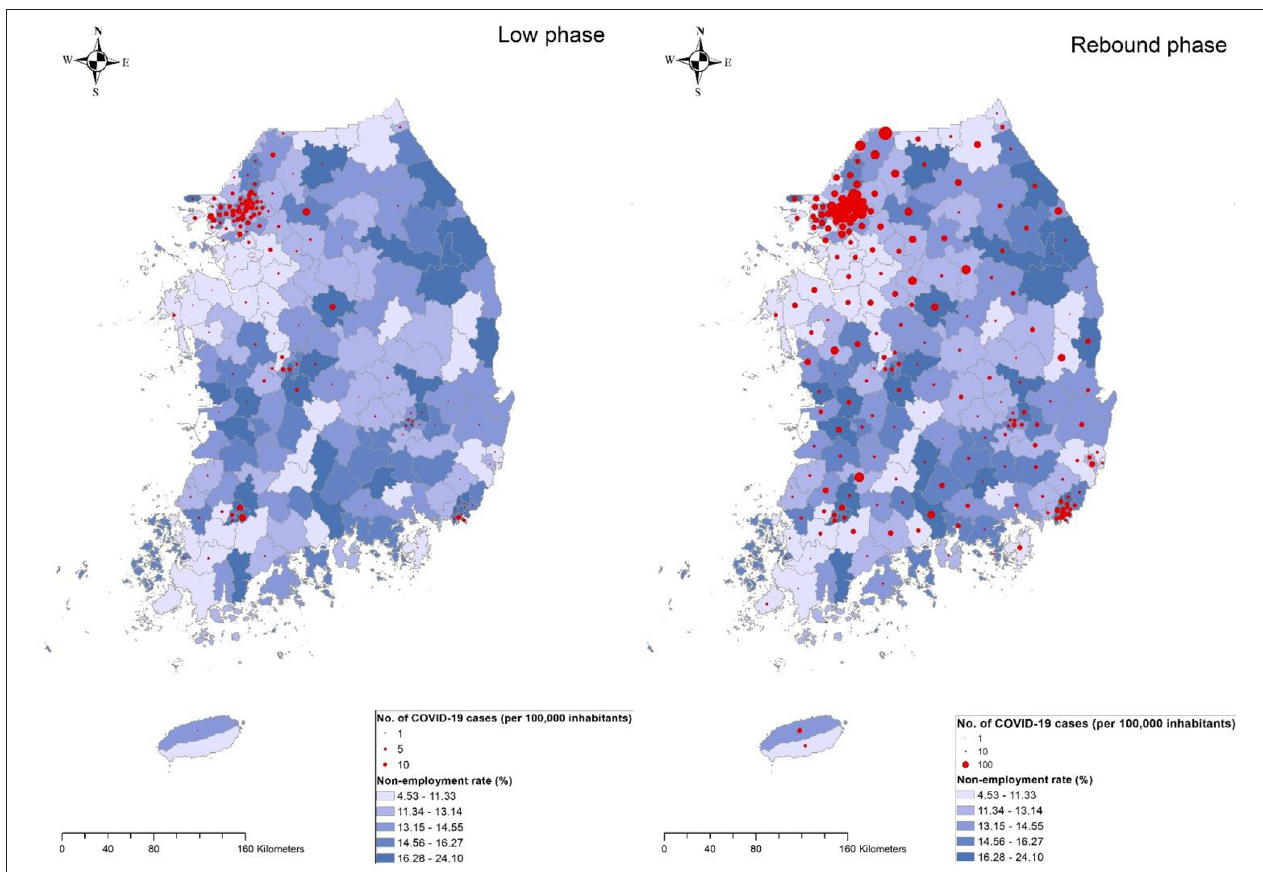
FIGURE 4 | Geographical distribution of nonemployment rate coupled with COVID-19 incidence rate by 229 municipalities during the low phase of the epidemic ( left ) or the rebound phase ( right ). The size of the circle is proportional to the cumulative number of reported COVID-19 cases per 100,000 inhabitants during the corresponding period. Blue gradient represents the magnitude of the nonemployment